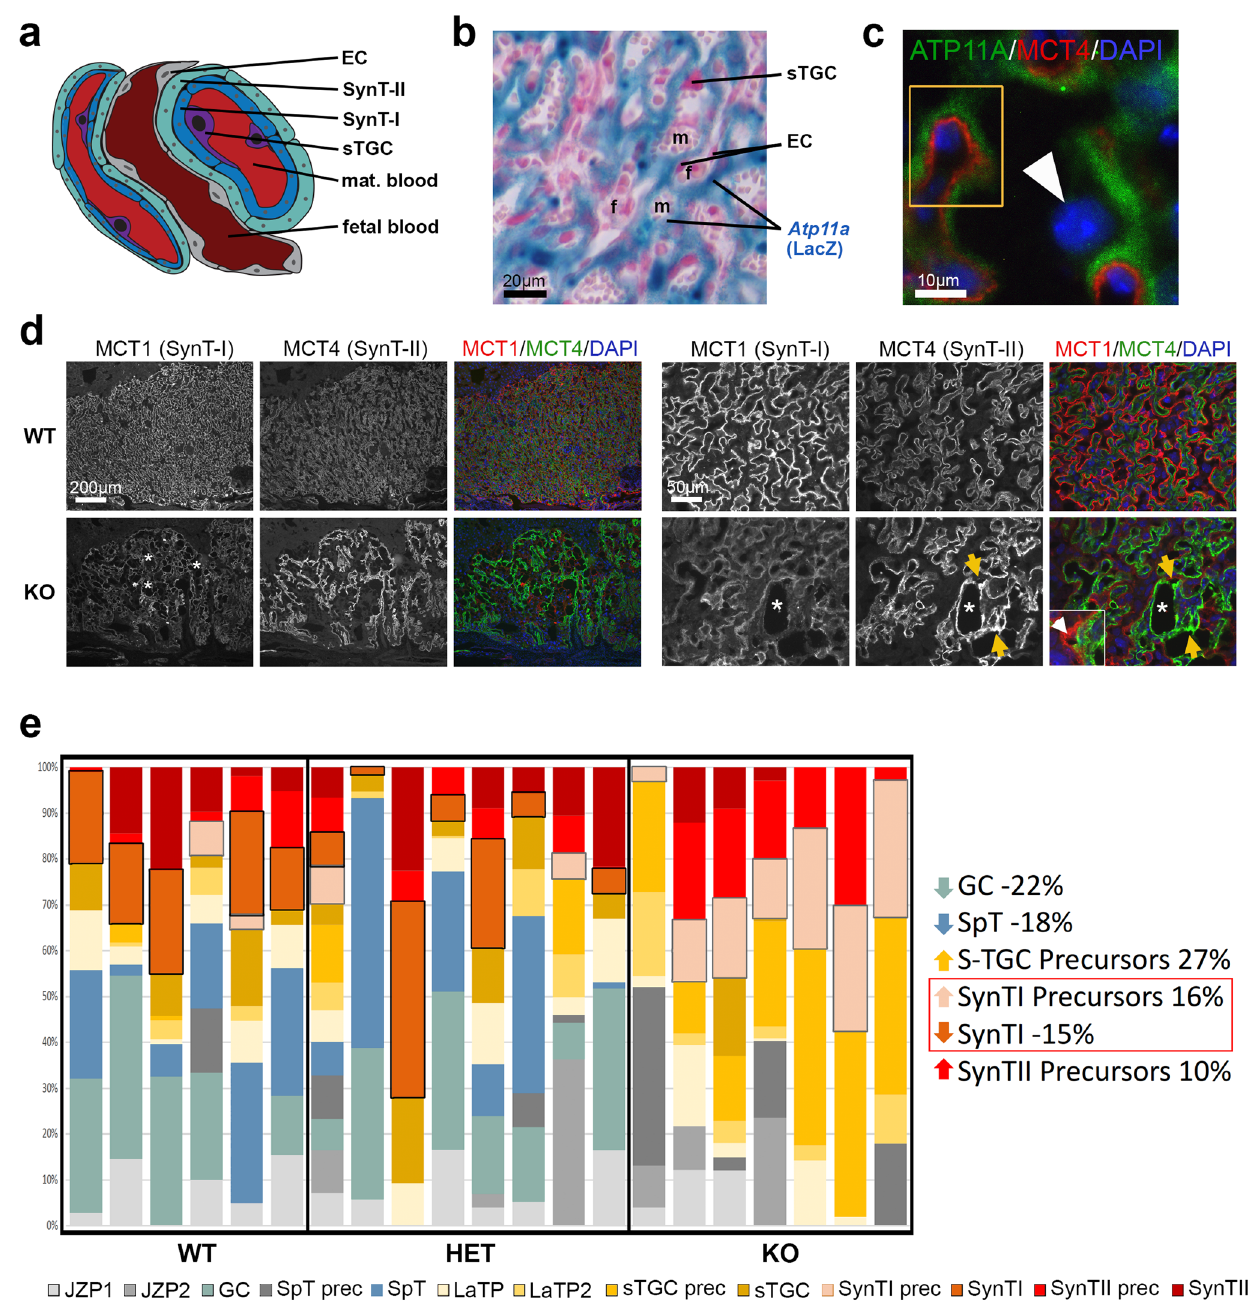
Fig. 5 | Speci fi c placental pathologies in Atp11a mutants. a Diagram of the fi ne- structural organization of the mouse placental labyrinth, which forms the feto- maternalexchangearea.EC=endothelialcells;SynT-I=syncytiotrophoblastlayerI; SynT-II=syncytiotrophoblastlayerII;sTGC=sinusoidaltrophoblastgiantcell;mat. blood = maternal blood. b LacZ staining of an Atp11a +/ − placenta in which LacZ serves as readout of endogenous Atp11a expression. Atp11a expression locates to thesyncytiotrophoblast,whereasendothelialcells(EC)liningfetalblood(f)vessels and sinusoidal trophoblast giant cells (sTGCs)facing maternalblood (m)sinusoids are not stained. Staining is representative of n =6 placentas. c Double immuno- fl uorescence staining for beta-galactosidase as indicator of ATP11A expression (green) and for MCT4 (red) as marker of the syncytiotrophoblast layer-II (SynT-II). The closely juxtaposed but non-overlapping staining (yellow rectangle) demon- stratesthatATP11Aiscon fi nedtoSynT-I.ThearrowheadpointstoansTGCnegative for ATP11A. Stainings are representative of n =3 placentas. d MCT1/MCT4 double immuno fl uorescence staining on Atp11a WT and KO placentas, imaged at identical